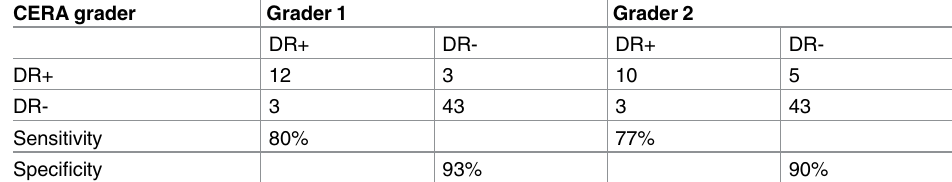
Table 10. Correctlyclassified retinal photos with and without DR by CERA grader and the local grad- ers in grading DR after learning from a test set of 32 eyes graded by the CERA